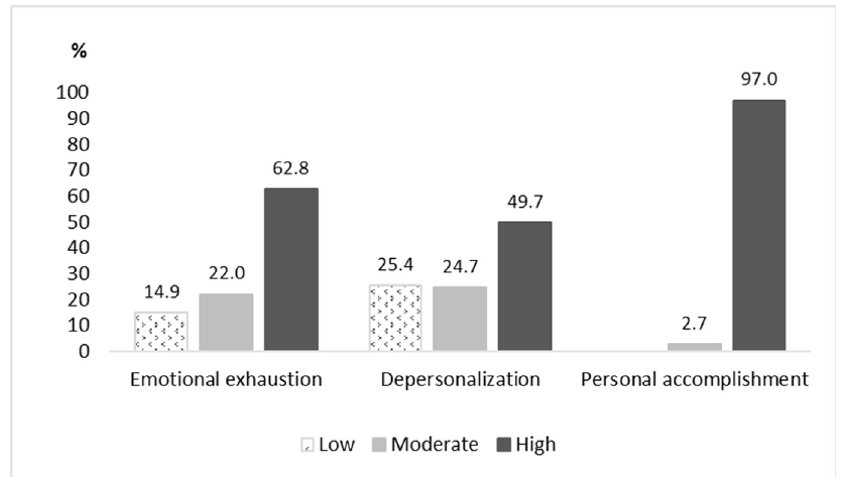
Fig 1. Burnout rate according to The Maslach Burnout Inventory (MBI)-Thai version.